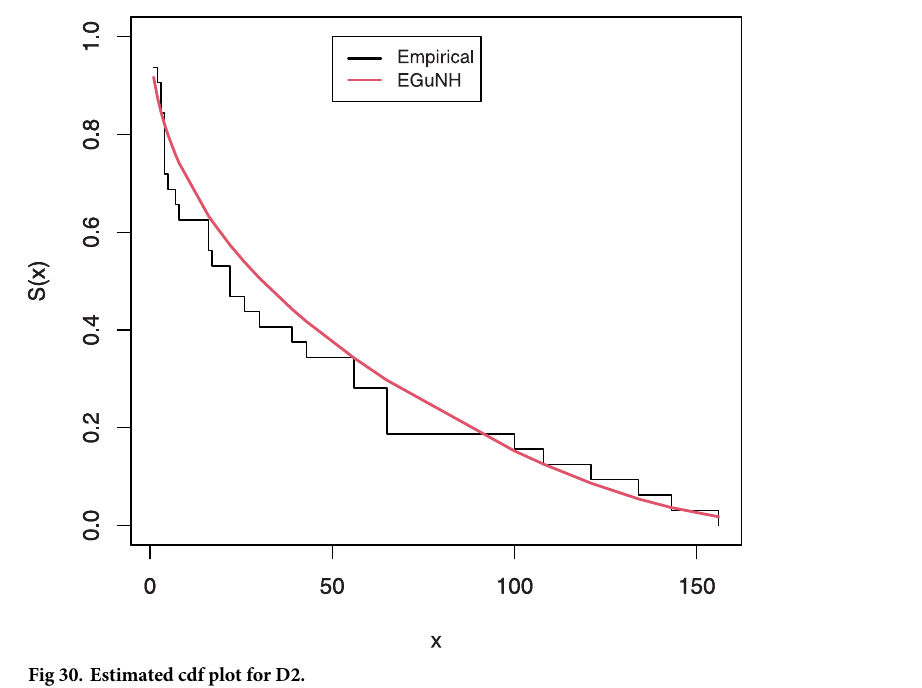
Fig 30. Estimated cdf plot for